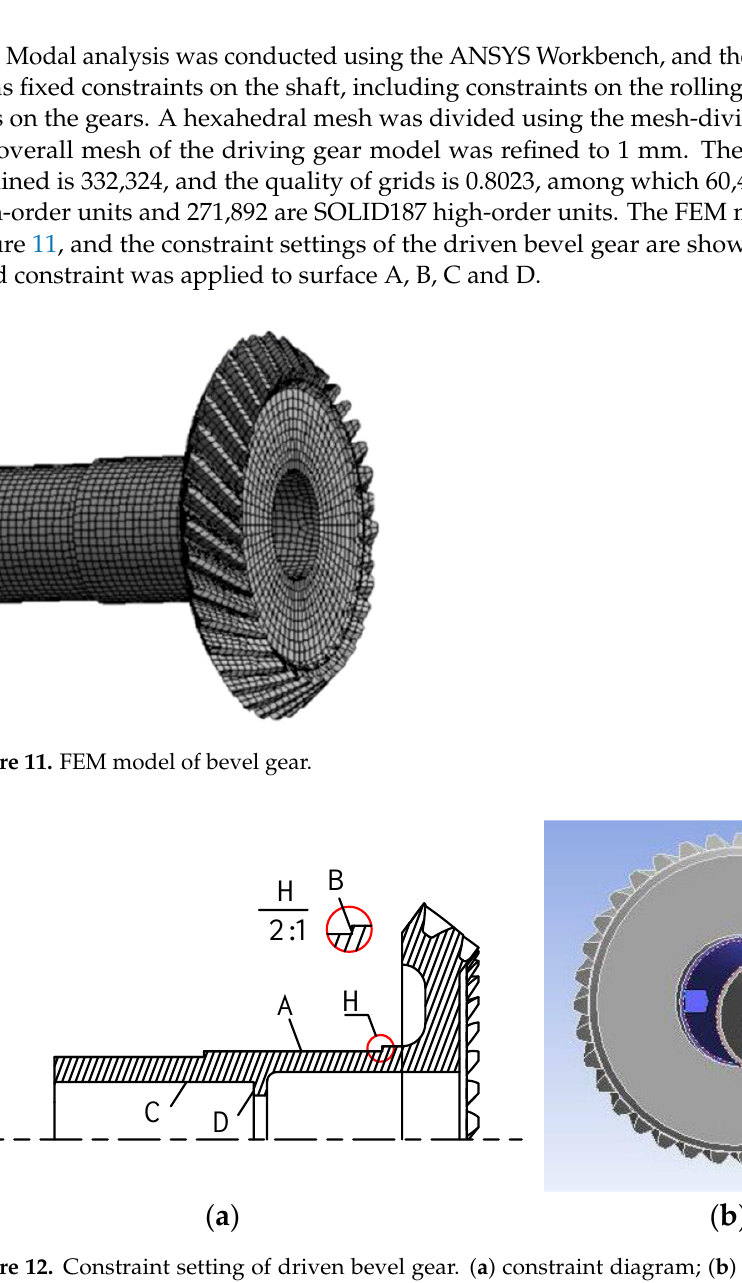
Table 3. Static frequency of vibration mode.